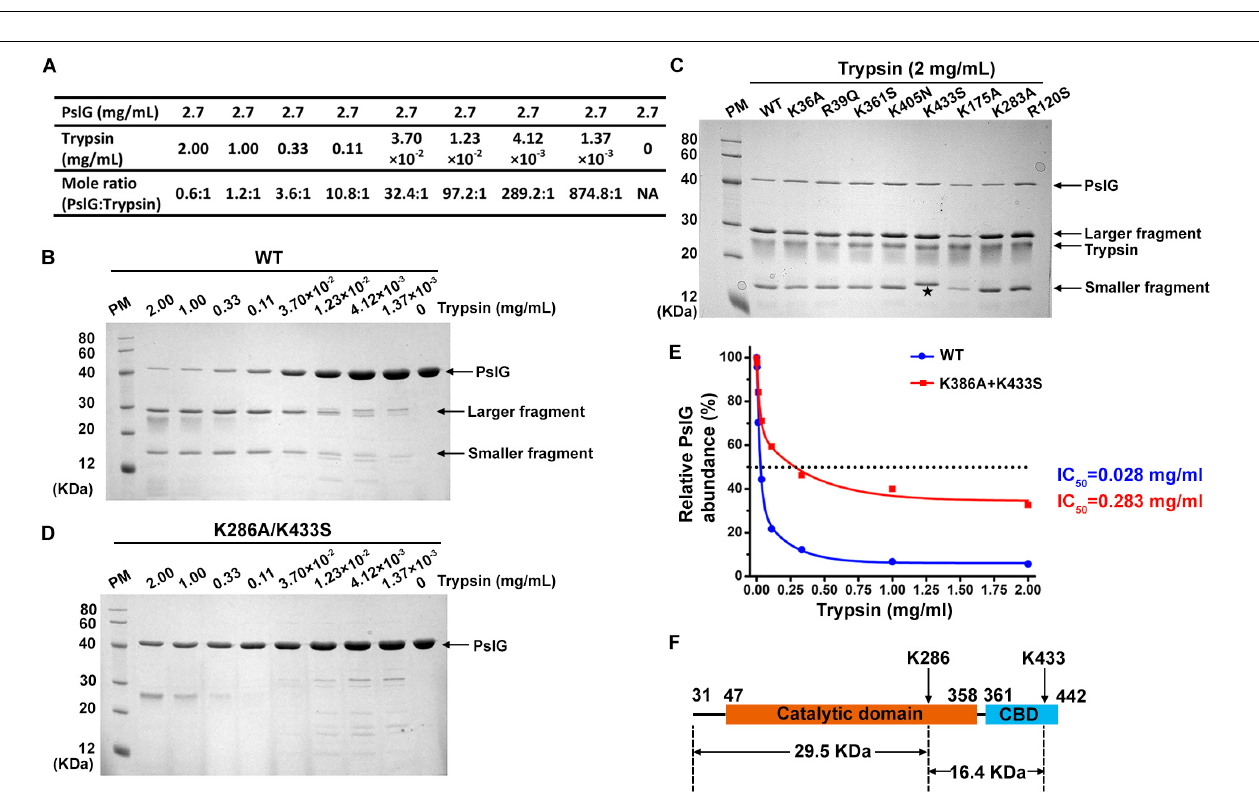
FIGURE 3 | Trypsin proteolysis of wild-type and mutant PslG. (A) The corresponding molar ratios of PslG to trypsin used in the experiments are shown. (B) The proteolysis of wild-type PslG treated with different concentrations of trypsin for 30 min at 37 ◦ C. The larger and smaller stable bands generated after digestion are marked by arrows. (C) Sodium dodecyl sulfate–PAGE showing the proteolysis characteristics of wild-type and single mutant PslG variants when treated with 2 mg mL - 1 trypsin for 30 min at 37 ◦ C. The smaller fragment generated by PslG K 433 S is marked with an asterisk. (D) The proteolysis of PslG K 286 A / K 433 S by different concentrations of trypsin for 30 min at 37 ◦ C. (E) Quantification of PslG abundances in (B) and (D) using ImageJ software. The highest PslG intensity was set as 100%. (F) The diagram showing trypsin cleavage in PslG.